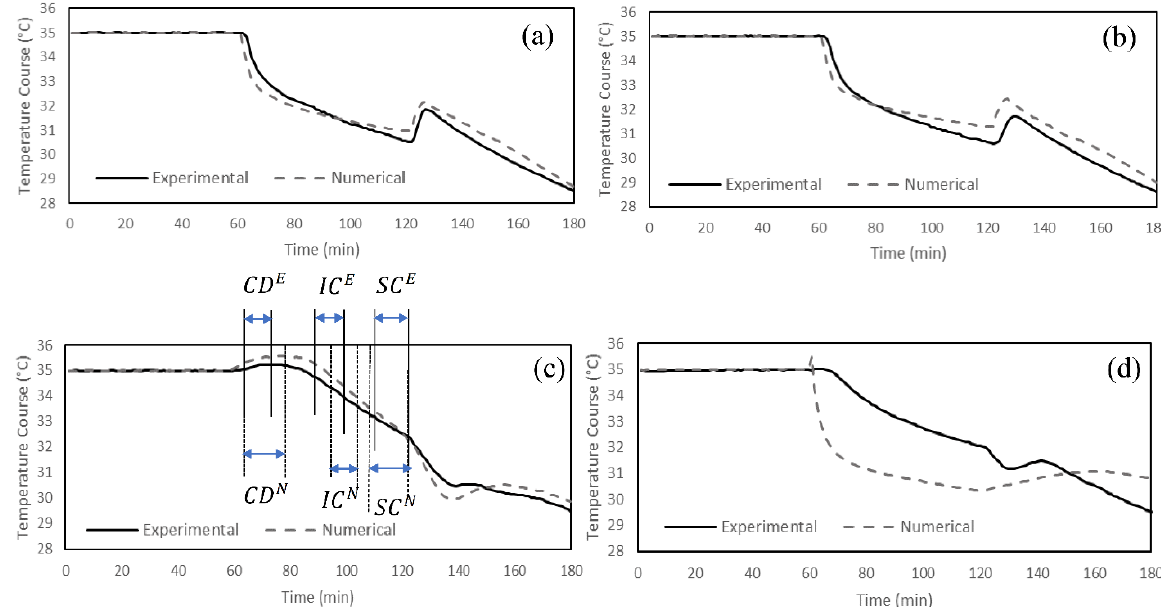
Figure 4. Temperature course during 3 phases of measurements for ( a ) Fabric A, ( b ) Fabric B, ( c ) Fabric C, and ( d ) Fabric D.